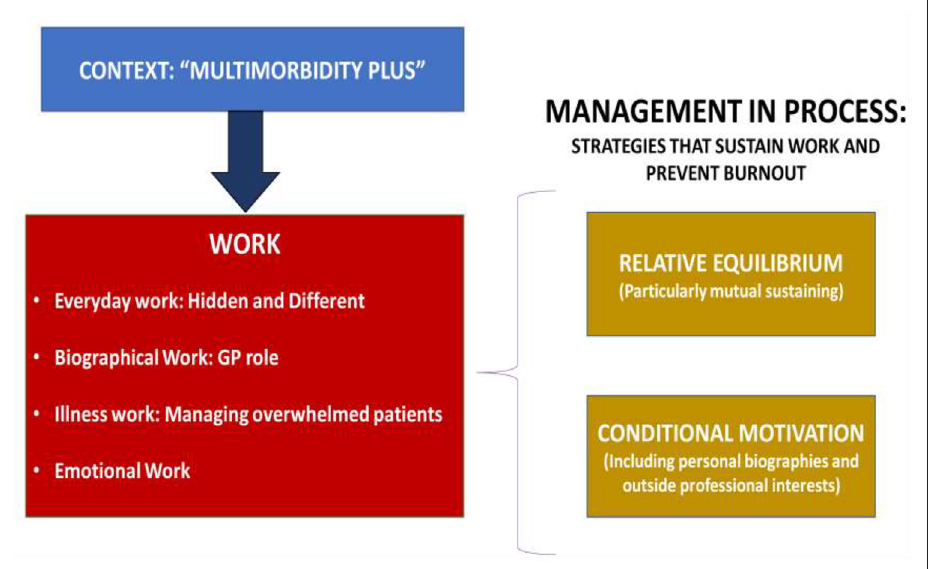
Figure 1 Summary of themes, subthemes, and their relation to one